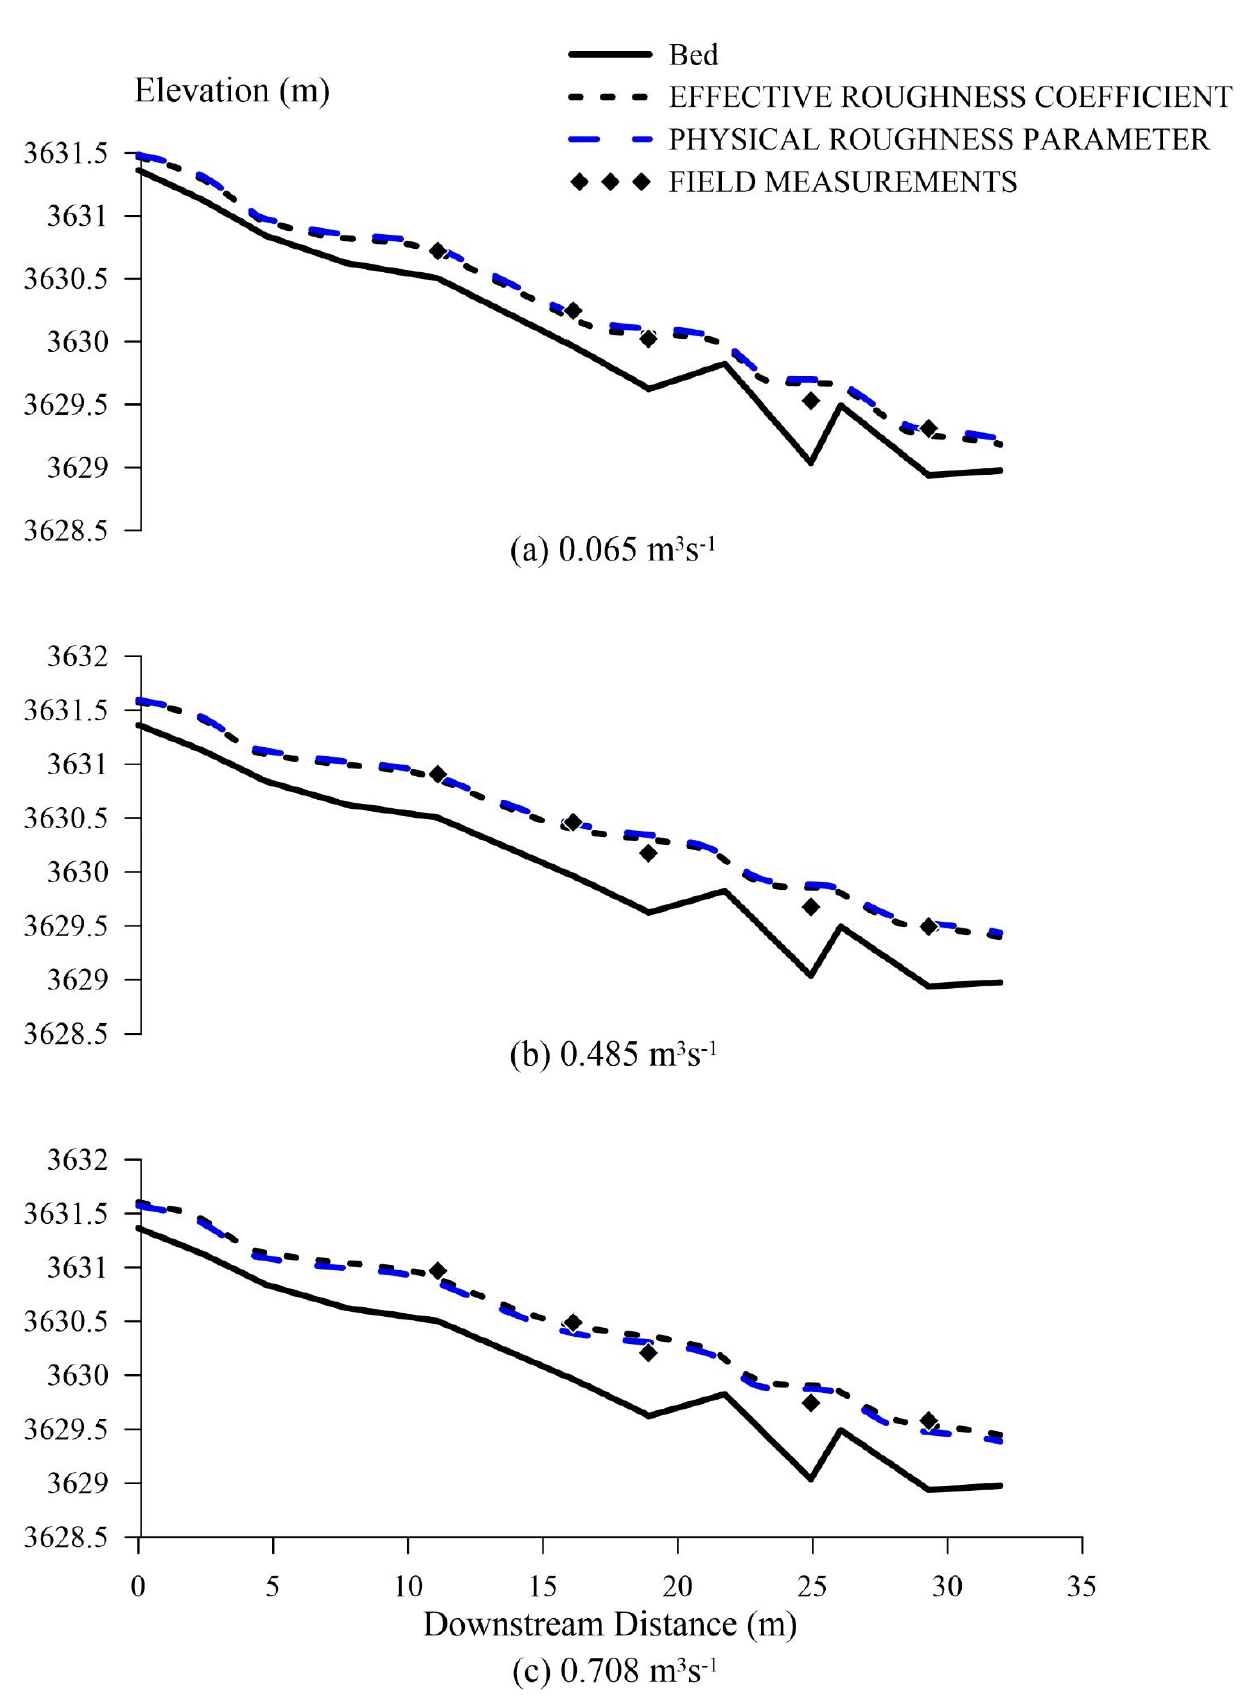
Figure 7. Water surface profiles using ERC and PRP in Cascade. ( a ) 0.065 m 3 s −1 ( b ) 0.485 m 3 s −1 ( c ) 0.708 m 3 s −1 .